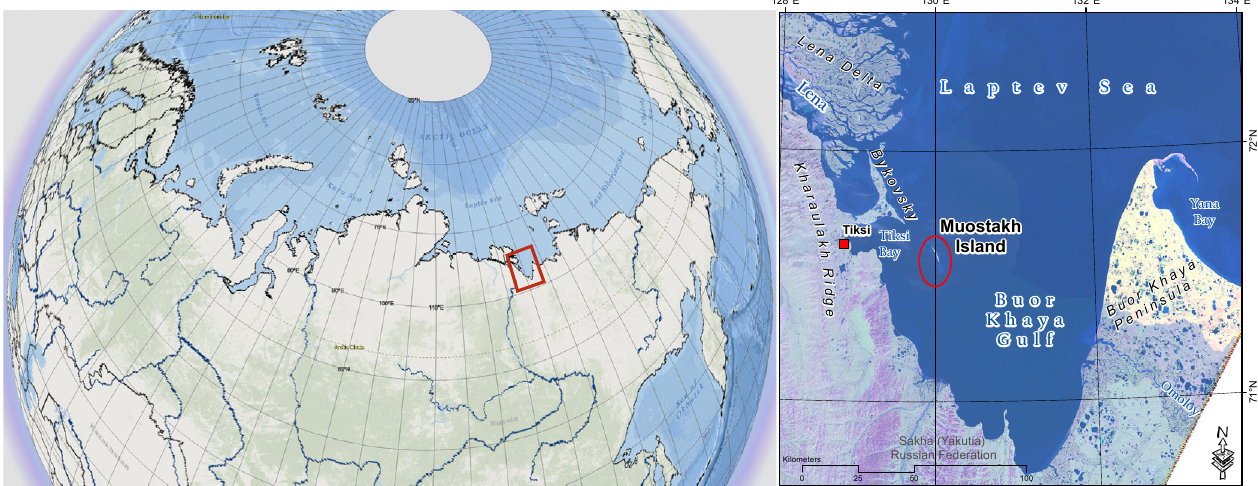
Figure 1. Left: situation of the right-hand map in East Siberia (Russia; source: ESRI). Right: location of Muostakh Island within Buor Khaya Gulf, central Laptev Sea (September 2010 Landsat-5 imagery as